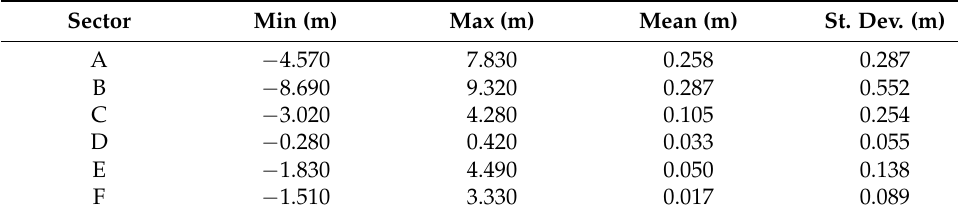
Table 8. Statistical terms of the differences of MBD values along y direction. Sector